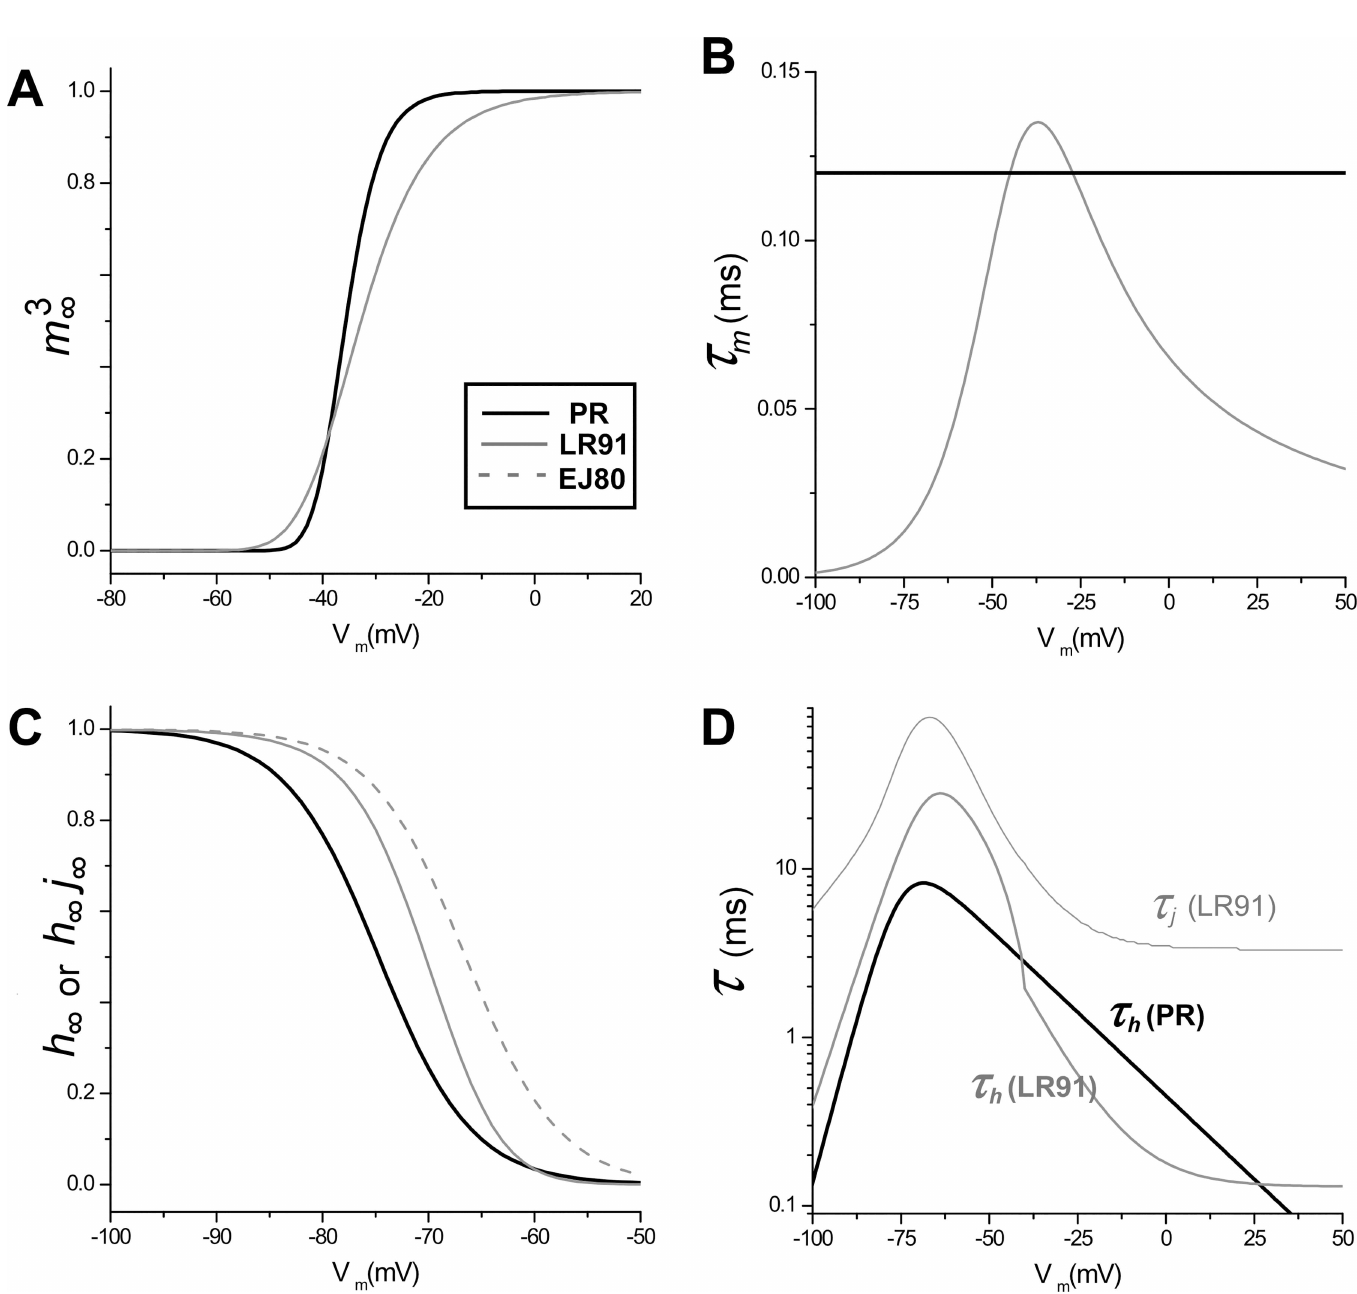
Fig 4. Voltage dependenceof steady state I Na activation (A), time constant for activation (B), steady state I Na inactivation(C), and time constant for inactivation(D) for the PR (black), LR1 (grey), and EJ (dashed grey) models (note the log